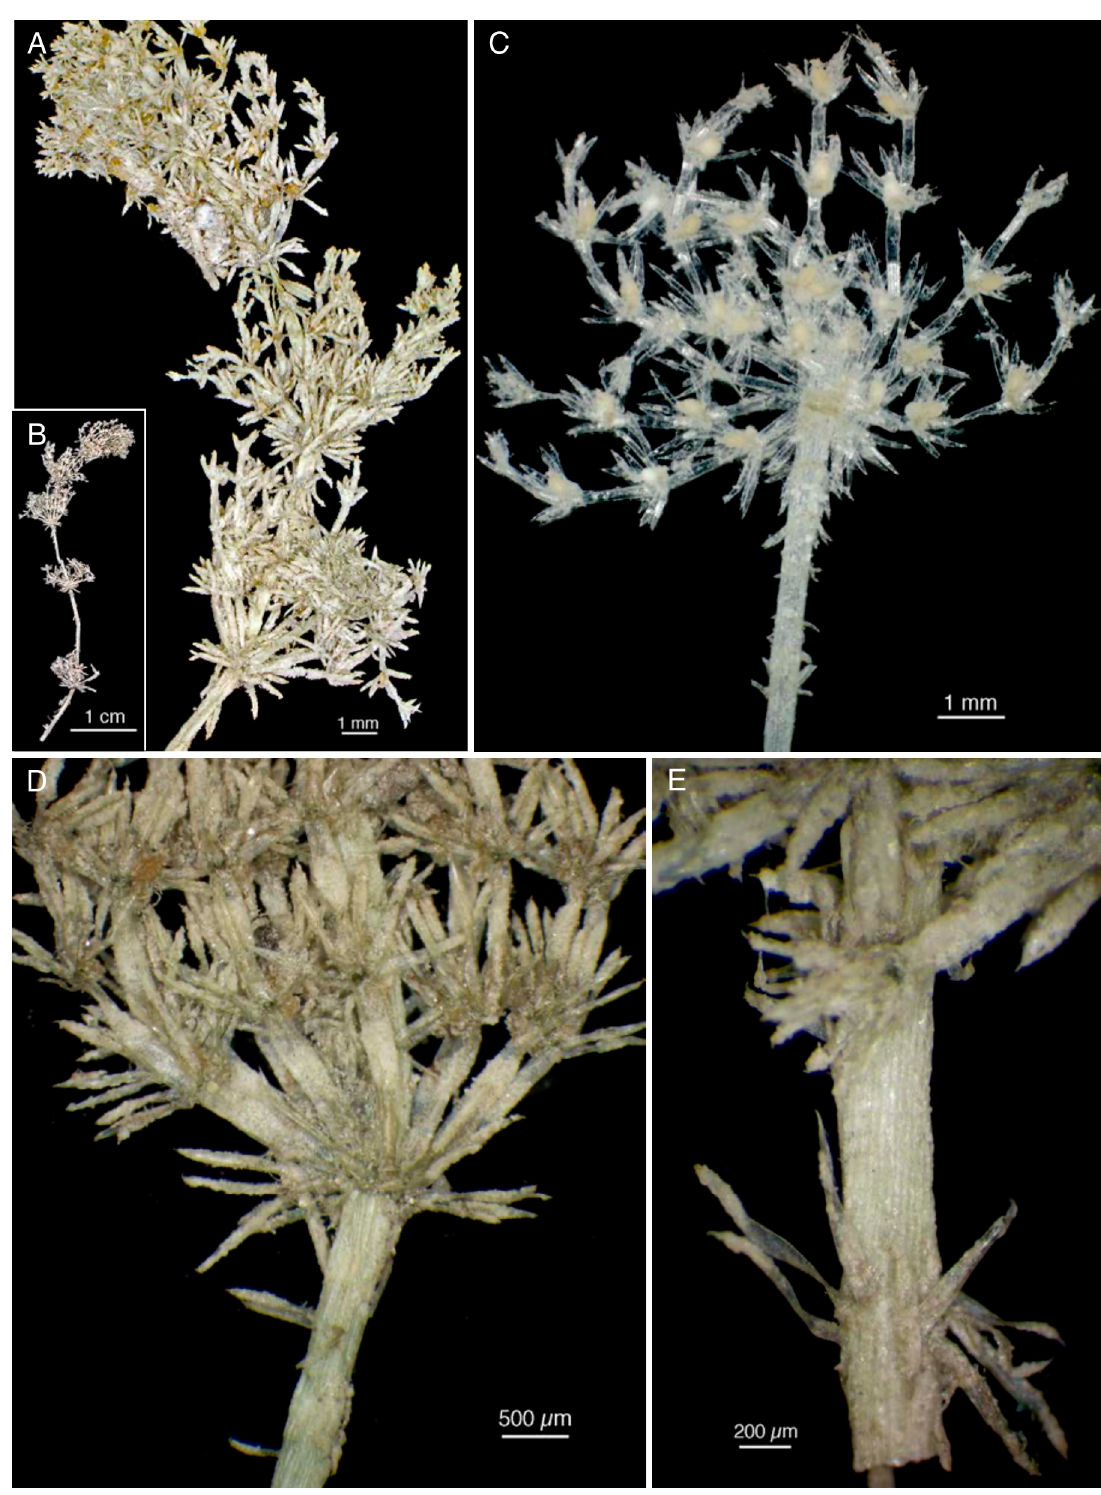
Figure 9. Morphologies of the portions removed from the specimens collected by Ferrari from S. Anna. (1 October 1886). ( A – D ) From the MOD specimen; ( C ) Details of the cortex; ( D ) Details of the stipulodes; ( E , F ) From the TO specimen (N. 3); ( G ) From the PAD portion.